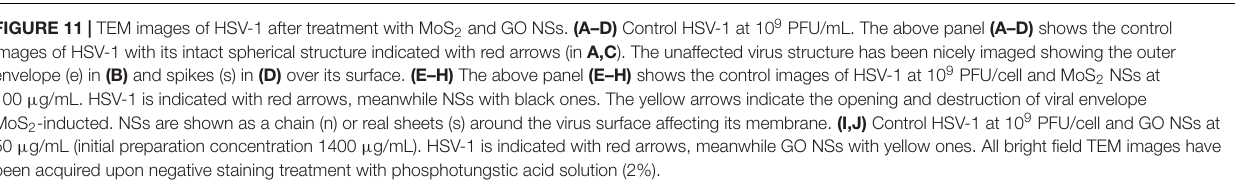
FIGURE 11 | TEM images of HSV-1 after treatment with MoS 2 and GO NSs. (A–D) Control HSV-1 at 10 9 PFU/mL. The above panel (A–D) shows the control images of HSV-1 with its intact spherical structure indicated with red arrows (in A,C ). The unaffected virus structure has been nicely imaged showing the outer envelope (e) in (B) and spikes (s) in (D) over its surface. (E–H) The above panel (E–H) shows the control images of HSV-1 at 10 9 PFU/cell and MoS 2 NSs at 100 µ g/mL. HSV-1 is indicated with red arrows, meanwhile NSs with black ones. The yellow arrows indicate the opening and destruction of viral envelope MoS 2 -inducted. NSs are shown as a chain (n) or real sheets (s) around the virus surface affecting its membrane. (I,J) Control HSV-1 at 10 9 PFU/cell and GO NSs at 50 µ g/mL (initial preparation concentration 1400 µ g/mL). HSV-1 is indicated with red arrows, meanwhile GO NSs with yellow ones. All bright field TEM images have been acquired upon negative staining treatment with phosphotungstic acid solution